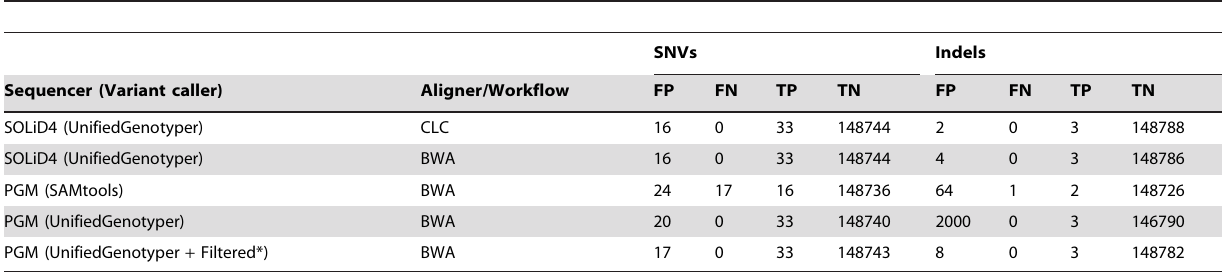
Table 2. Variants in BRCA1 and BRCA2 detected by different platforms and filter